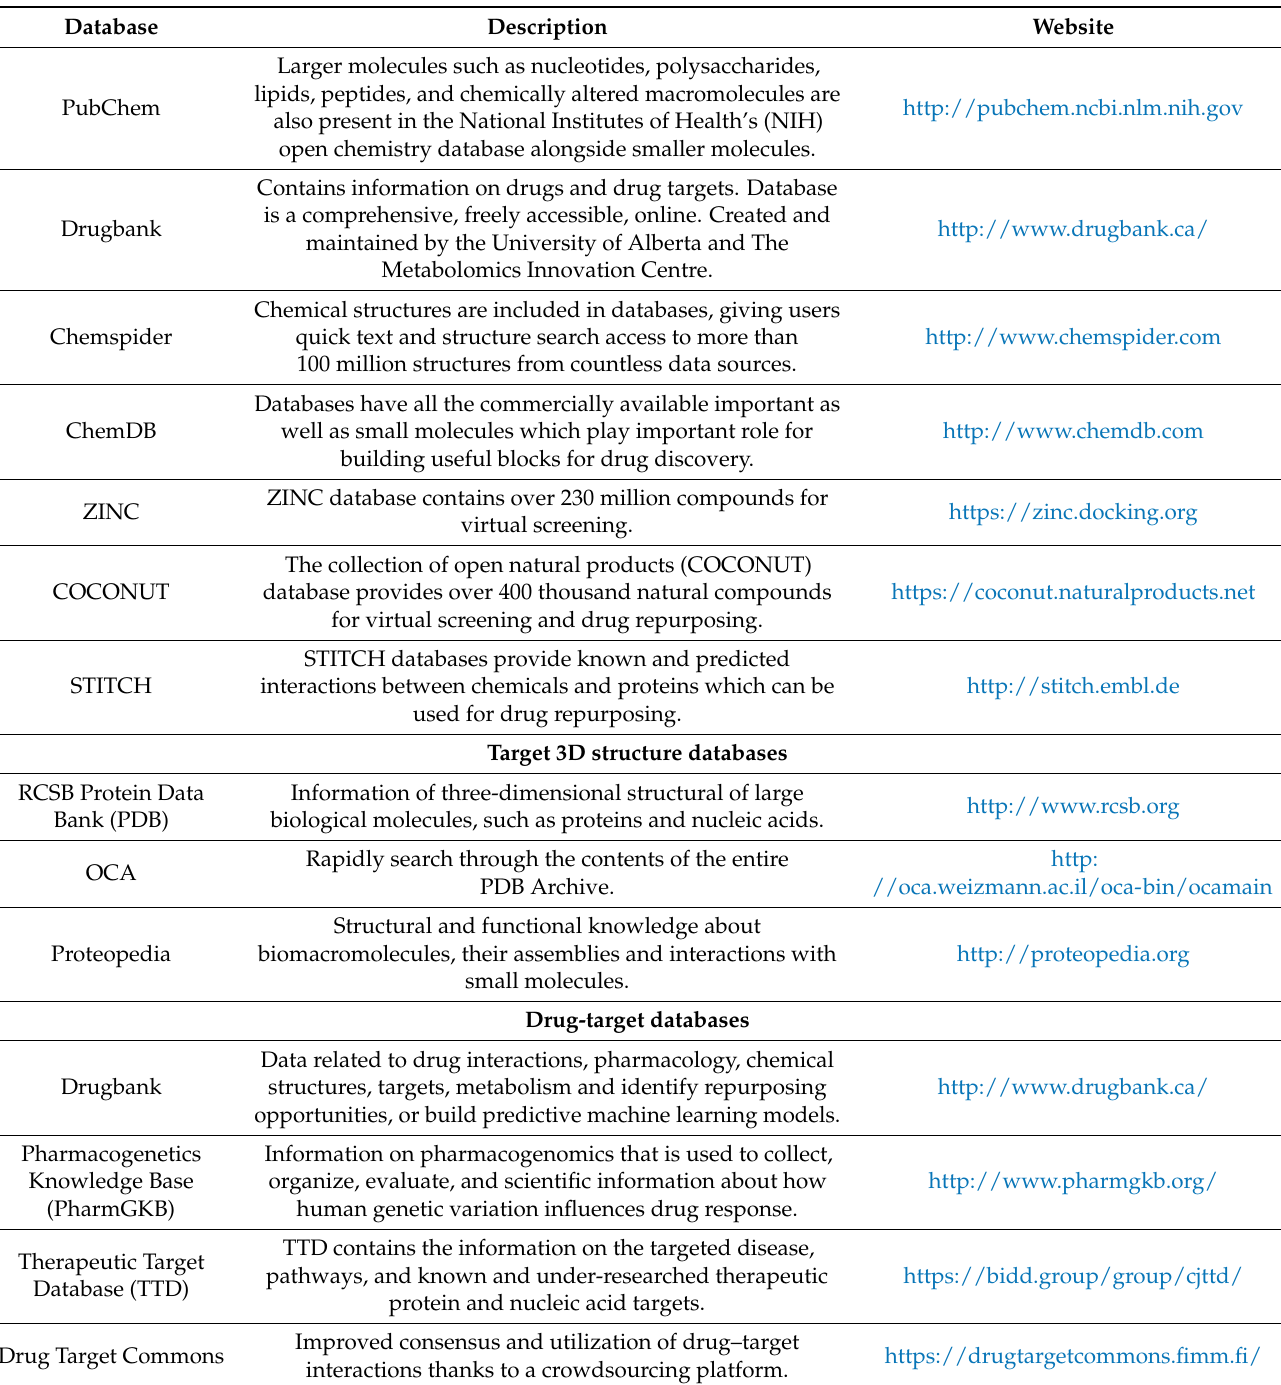
Table 1. Summary of available drug/molecule databases applicable for different drug repurposing